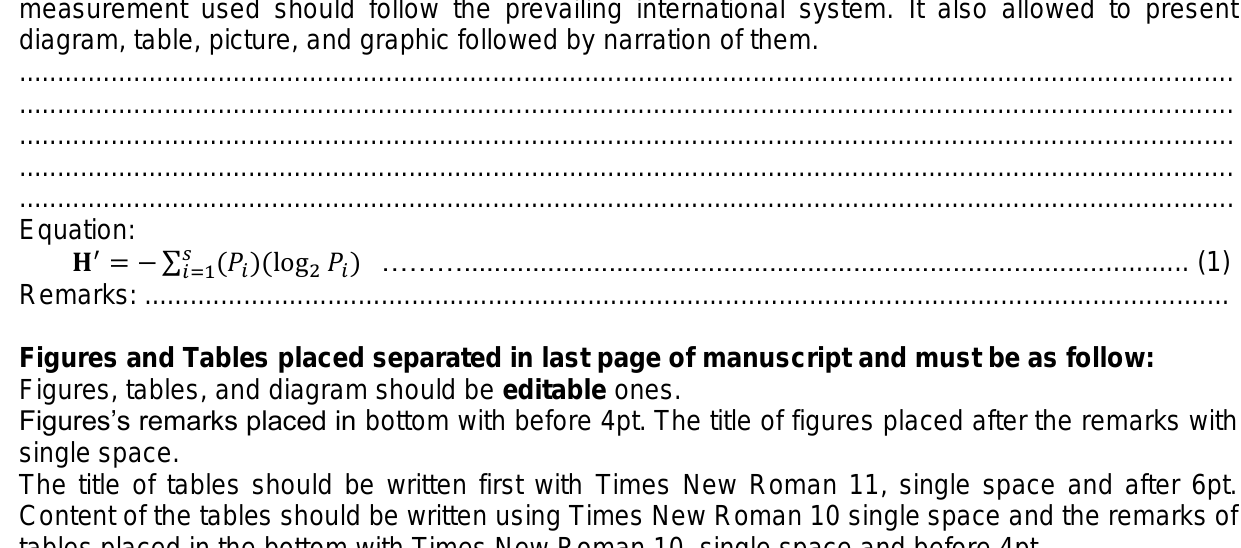
Table 1. Effects of plant growth regulator types and concentrations on embryogenic callus induction